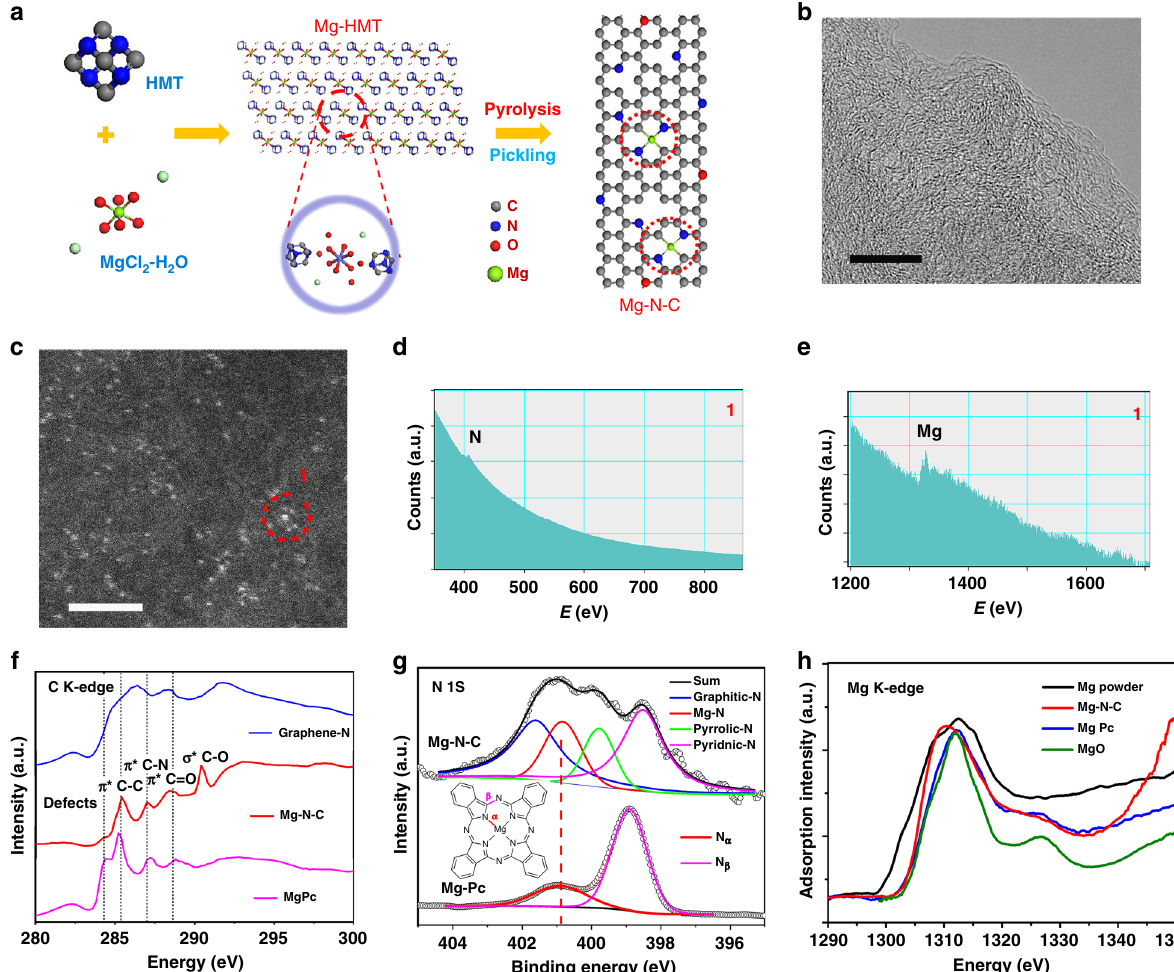
Fig. 3 The synthesis and characterization of Mg – N – C. a Schematic illustration of the synthesis procedure of Mg – N – C. The red dash circles at Mg – N – C represents the active centers. b High resolution transmission electron microscopy (HRTEM) of Mg – N – C. Scale bar: 5 nm. c High-angle annular dark- fi eld- scanning transmission electron microscopy (HAADF-STEM) image of Mg – N – C. Scale bar: 2 nm. The bright dots are Mg atoms, which can be con fi rmed by electron energy loss spectroscopy (EELS) spectra in d , e , probe resolution is 0.15 nm. d , e The EELS spectrum for atomic site highlighted by red circle in c . f C K-edge XANES spectrum of Graphene-N, Mg – N – C and MgPc. g The XPS result of the N 1s spectrum for Mg – N – C and MgPc. h The XANES of Mg K-edge for